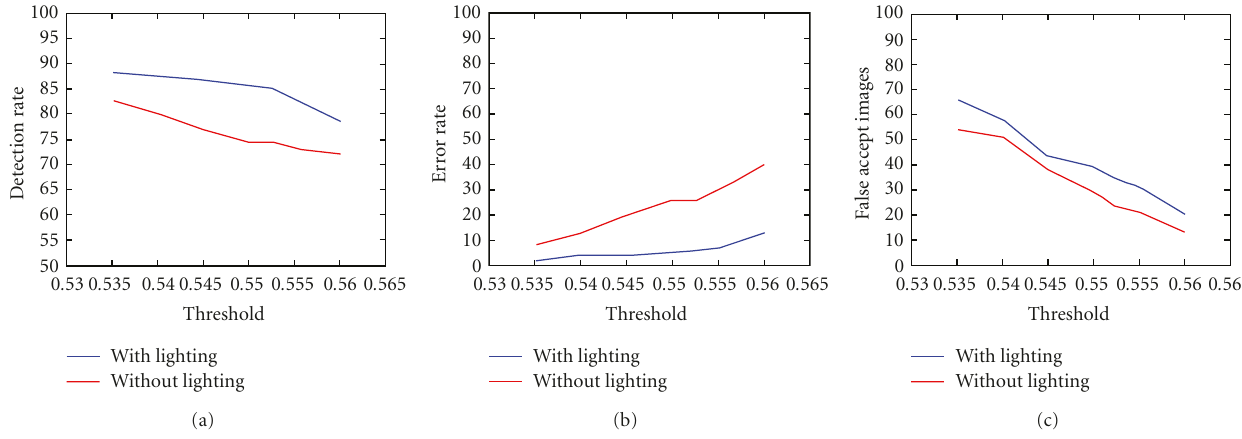
Figure 16: The performance of face detectors in di ff erent thresholds for (a) the detection rates, (b) The error rates, (c) The numbers of false accept images.